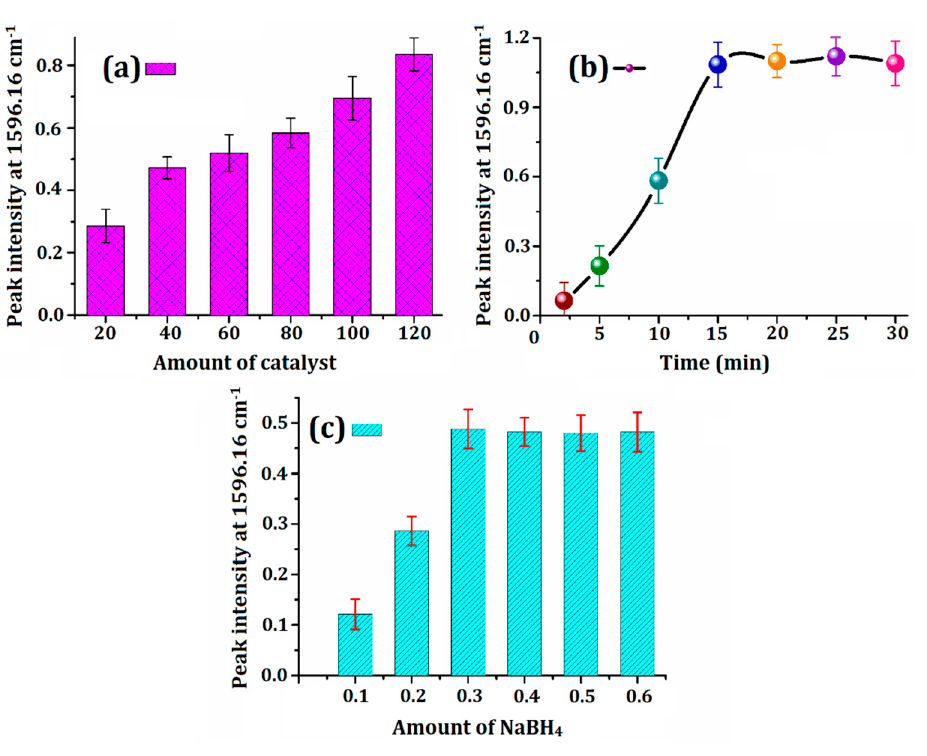
Figure 14. Optimized condition for catalysis process ( a ) effect of amount of catalyst, ( b ) effect of time and ( c ) effect of amount of NaBH 4 . and ( c ) effect of amount of NaBH 4